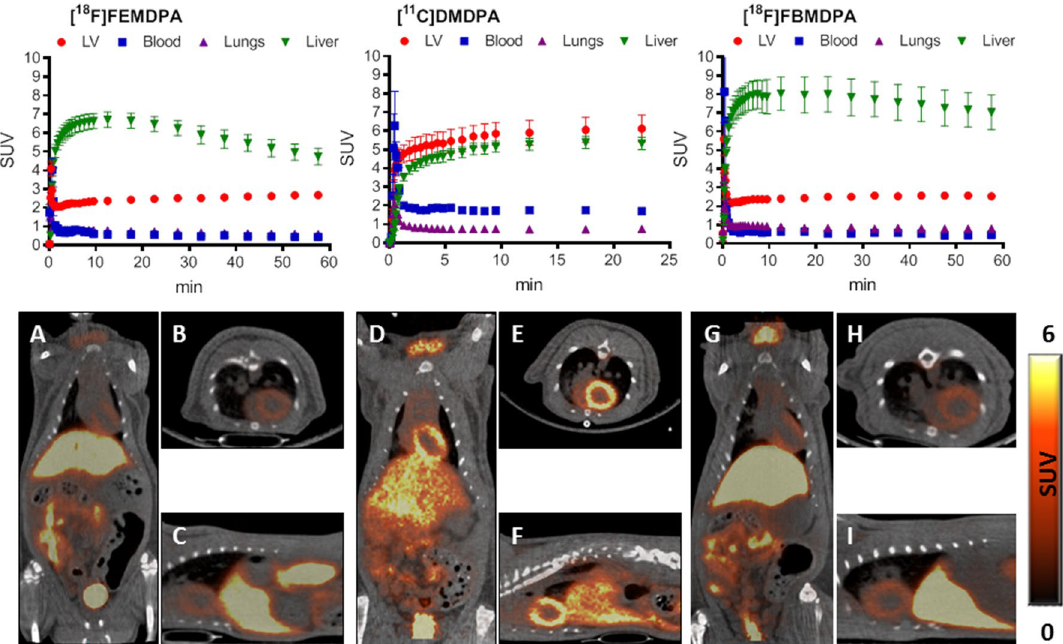
Figure 3. TACs of selected organs following i.v. injection of [ 18 F]FEMDPA (upper left, n = 4), [ 11 C]DMDPA (upper middle, n = 4) and [ 18 F]FBMDPA (upper right, n = 3) into male SD rats. Results are presented as mean ± SEM. Representative PET/CT of coronal ( A , D , G ), axial ( B , E , H ), and sagittal ( C , F , I ) slice images obtained following i.v. injection of [ 18 F] FEMDPA ( A – C ), [ 11 C]DMDPA ( D – F ) and [ 18 F]FBMDPA ( G – I ), into male SD rats. Images represent the summation of 15–25 min